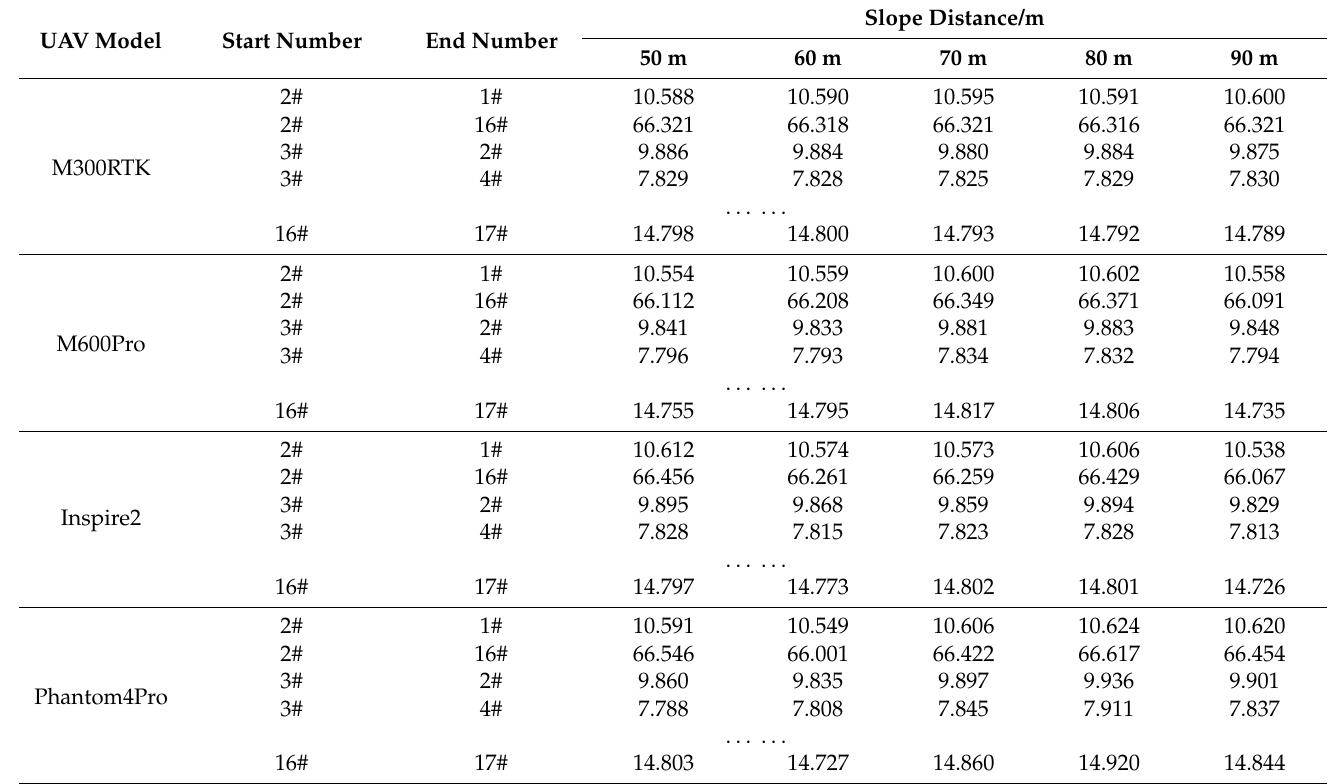
Table 3. Measurement distances for different 3D reconstruction models with different UAVs at different heights. (1#, 2#, 3#...... represents the number of the